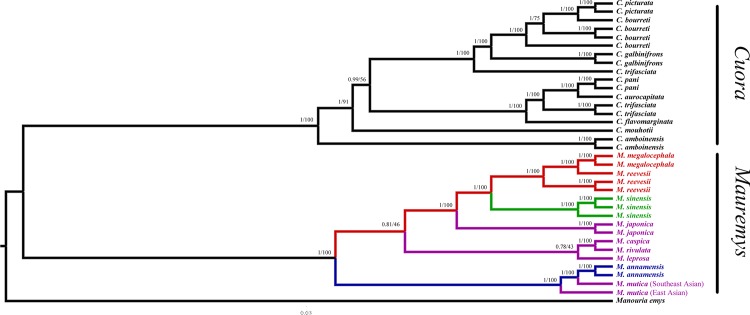
Phylogenetic trees for Mauremys sensu lato reconstructed based on mt heavy chain 12 protein-coding genes.Numbers of nearby branches are posterior probabilities (PPs, Left) and bootstrap proportions (BPs, Right) recovered from BI and ML analyses, respectively. Four old genera of Mauremys sensu lato are shown using different colours; i.e., red represents Chinemys; green represents Ocadia; purple represents Mauremys; blue represents Annamemys.